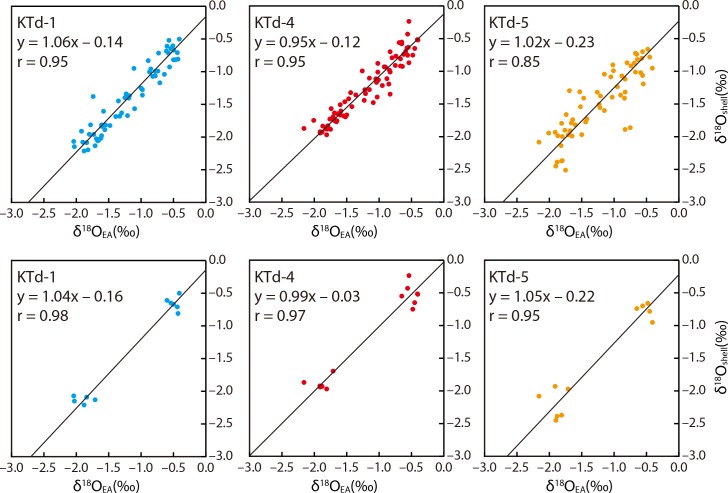
Cross-plots of monthly resolved δ18Oshell versus δ18OEA for the studied Tridacna derasa shells.All monthly resolved data are shown in the upper row. Annual maximum and minimum δ18Oshell values (= δ18Oshell values for the coolest and warmest months, respectively) are indicated in the lower row. Black line is the regression line.